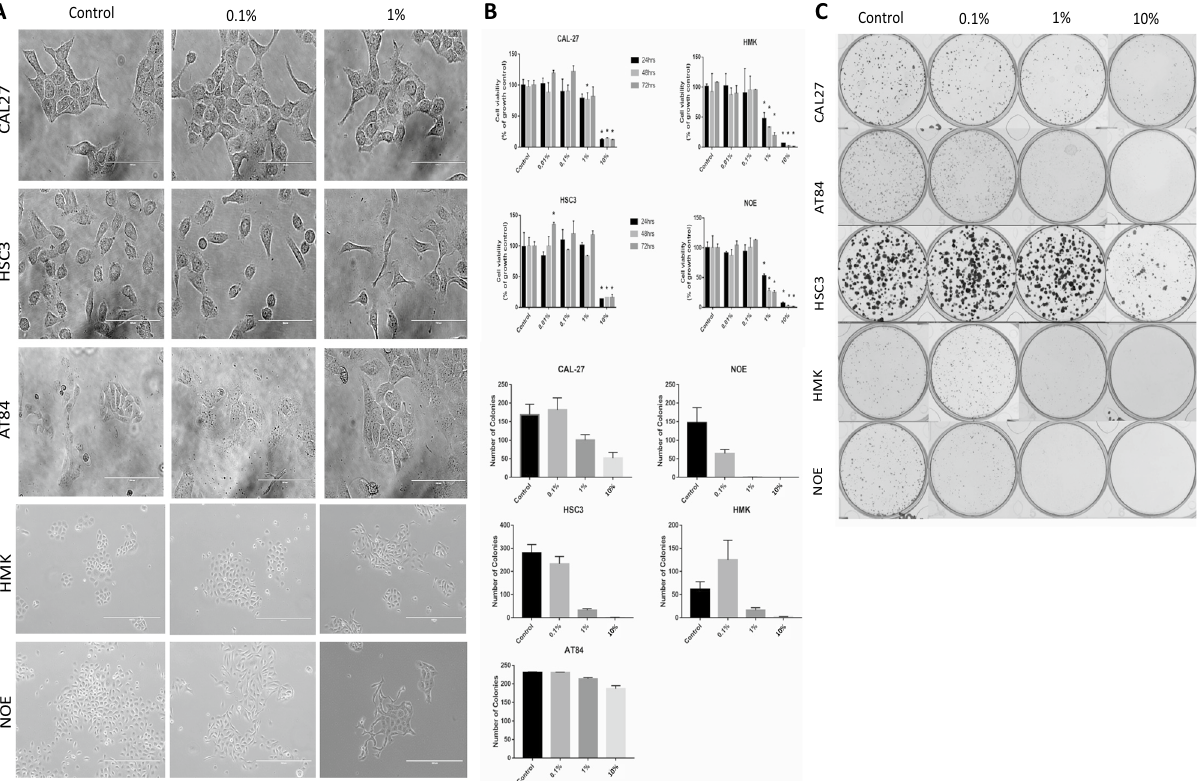
Figure 2. E-liquid exposure promotes change in cell morphology and survival of normal and malignant oral epithelial cells. ( A ) Representative images of the OSCC cell lines (CAL27, HSC3 and AT84) and normal oral epithelium cells (HMK and NOE) cell cultures treated at 0.1% (0.2 mg/mL) of e-liquid for 72 h before trypan blue staining. Magnification 200X illustrating changes in cell morphology. ( B ) E-liquid exposure resulted in increased cell death under concentrations above 1% for normal cells and 10% for OSCC cells. Results are shown as the mean percentage of cell death per sample ± SEM. Magnification 200X. ( C ) Colony counts were normalized to the untreated control cell cultures. Graphed results are given as mean colony count ± SEM. *represents significant difference between the control group* P < centration of 0.1% (v/v) of e-liquid showed significant alteration in cell morphology compared to the control (Fig. 2A). However, there was an overall decrease in cell viability when samples were treated with high concen- trations of e-liquid solutions (10% v/v) for a long period (72 h) compared to the untreated control (Fig. 2B). This pattern was differently observed when comparing normal to OSCC cell lines stimulated with > 1% concentration of e-liquid solution. At this high concentration, HMK and NOE presented a significant decrease in cell viabil- ity, whereas OSCC cell lines maintained their viability to similar percentages observed in untreated controls (Fig. 2B). At lower concentrations, this differential susceptibility to e-liquid compounds was even more noticed as OSCC cell lines, which demonstrated a slight increase in proliferation as compared to control cells. To evaluate the survival of morphologically normal oral epithelial and OSCC cells exposed to varying doses of e-liquid treatment, clonogenicity assay was performed using cells treated with 0.1 and 1% e-liquid solutions (Fig. 2C). Tumor cells (CAL27, HSC3 and AT84) and normal cell lines (HMK and NOE) were treated for 7 days prior to colony enumeration. OSCC cell lines demonstrated a more resistant phenotype to e-liquid-induced cell death when compared to normal cells. In NOE, 1% by volume of e-liquid treatment resulted in 100% cell death. Our results also revealed a stepwise decrease in colony count and survival with increasing e-liquid doses (in both flavored and unflavored e-liquid), with a greater than twofold decrease in survival in all cell lines following exposure to only 1% by volume. The total number of colonies detected in OSCC cell lines were merely affected